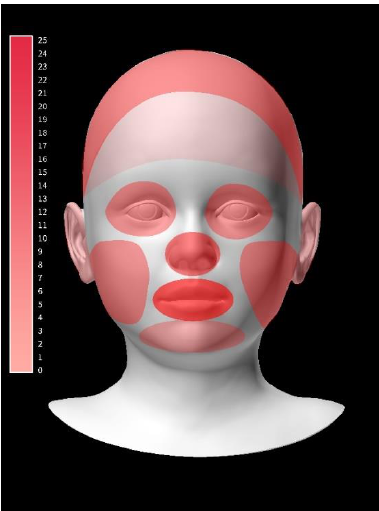
Figure 2. Visualizing frequency of hand-to-face contact (number/person/2 h). The color bar expresses the contact frequency from 0 to 25. The darker the color, the more frequent the contact. 3.3. Density Distribution of Frequency and Duration for Hand-to-Face Contact by Gender The density distribution of frequency and duration of mucosal contact, including the eyes, nose, and mouth, showed a wider distribution in boys than in girls (Figure 3).